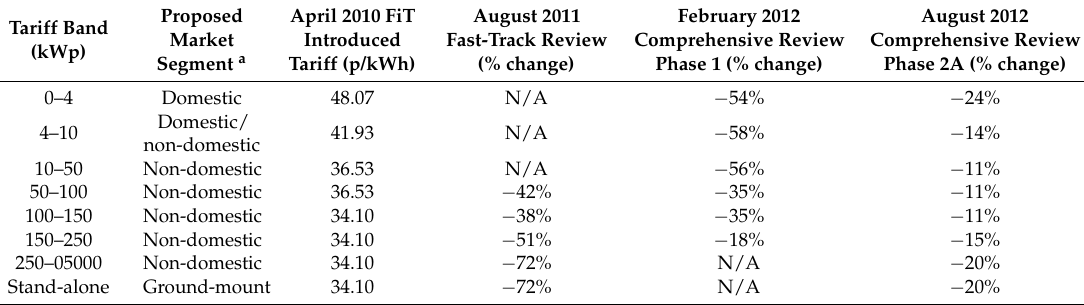
Table 2. Feed-in tariff banding and revisions for PV. Feed-in tariff: